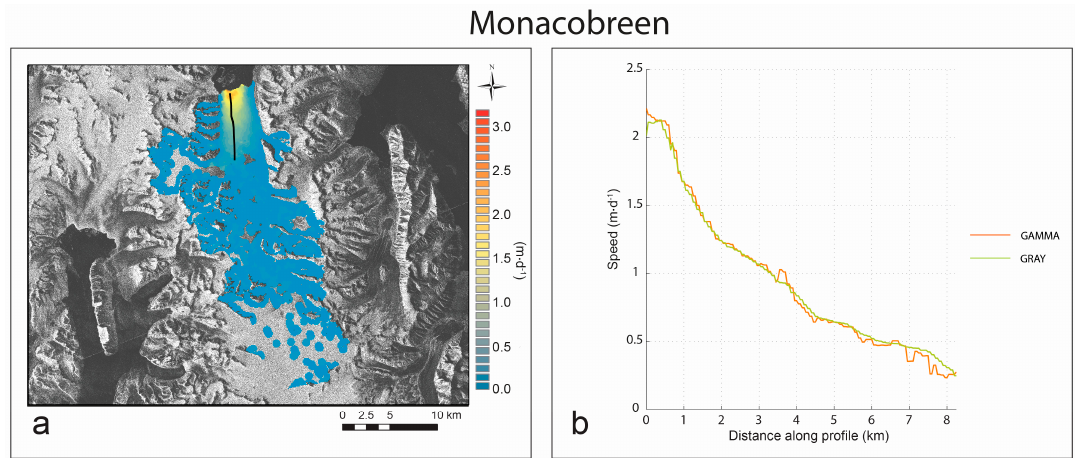
Figure 7. ( a ) Surface speed of the Monacobreen (#5 in Figure 3) in N-Spitsbergen (1–25 January 2013; WF; GRAY); and ( b ) speed profile along the centerline of Monacobreen (orange: GAMMA; green: GRAY).